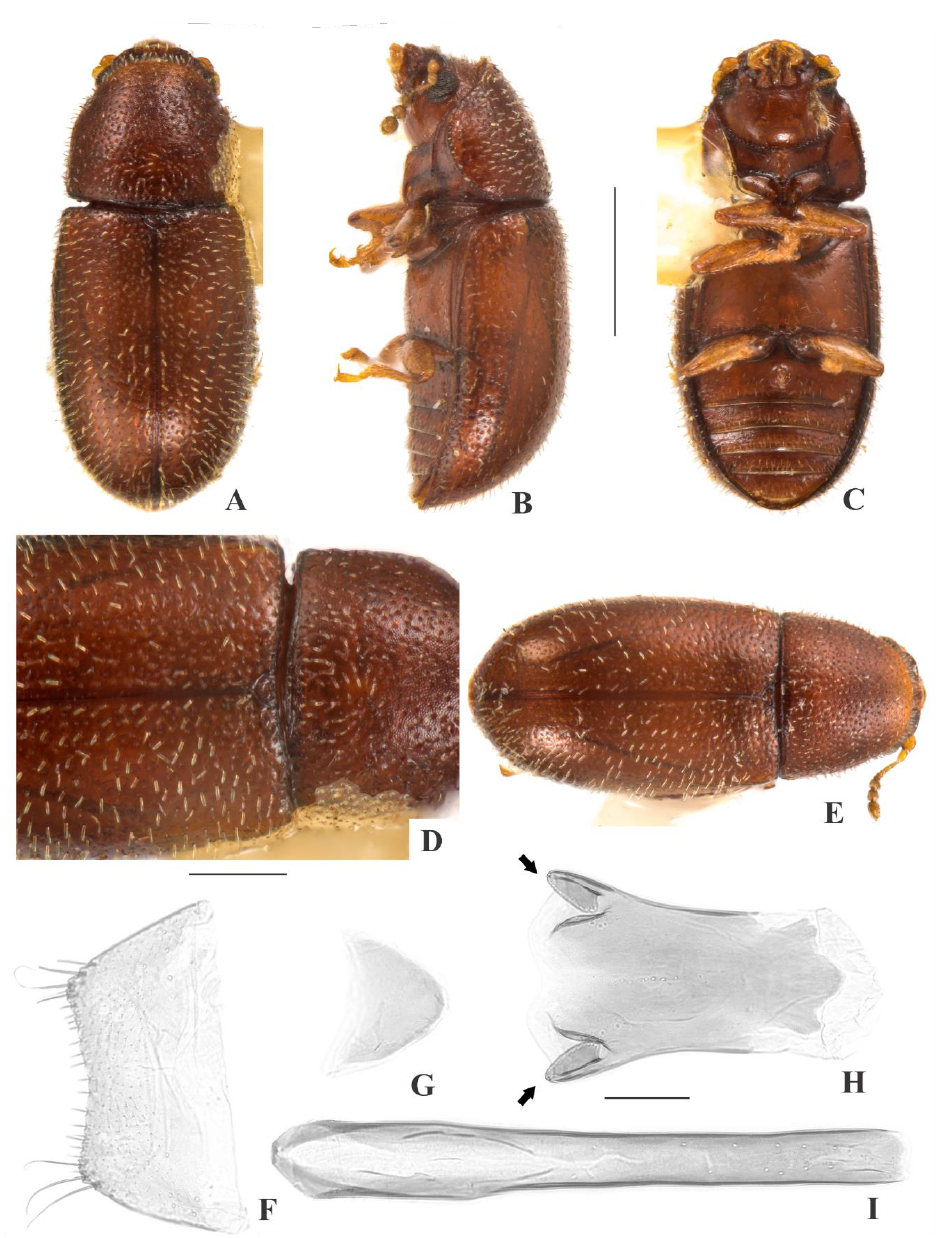
Figure 12. Cis westerncapensis sp. n. , male holotype ( A – D ), female paratype ( E ), aedeagus of paratype from Saasveld Forestry College ( F – I ): A. Dorsal view. B. Lateral view. C. Ventral view. D. Scutellar shield and part of the pronotum and elytra. F. Sternite VIII. G. Basal piece. H. Tegmen, note acute angulations at apex (black arrows). I. Penis. Scale bars: 0.5 mm ( A – C , E ), 0.2 mm ( D ), 0.05 mm ( F – I ).